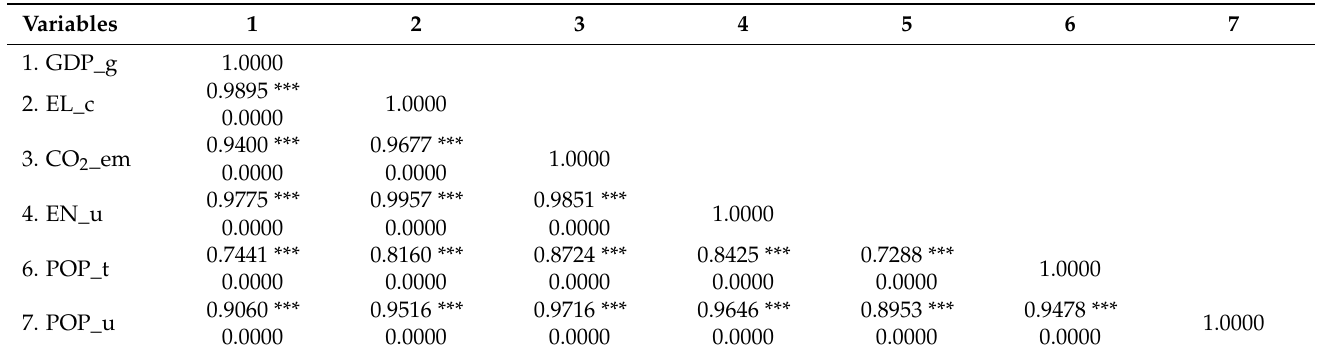
Table 3. Correlation Matrix.